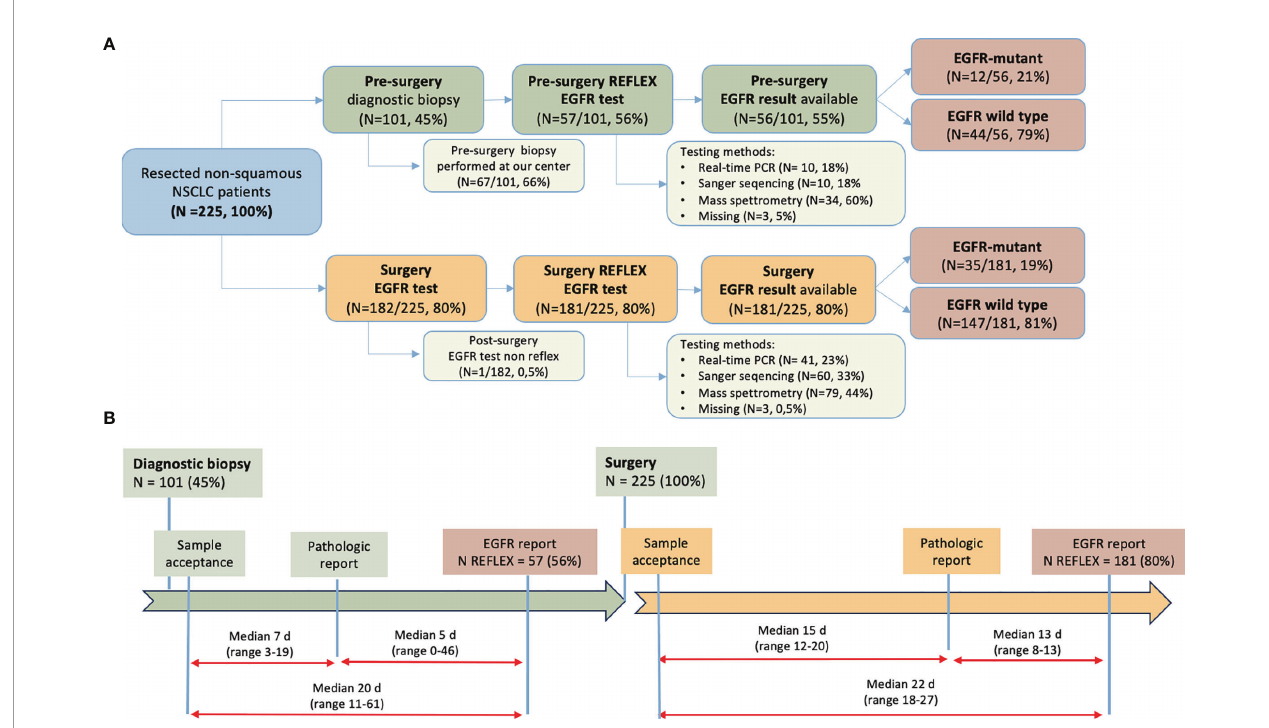
FIGURE 1 | Diagnostic-therapeutic pathway of patients enrolled. (A) Patient fl ow according to EGFR-testing time, material, methods used, and result; (B) Turnaround time between diagnostic procedure and pathological and molecular report, pre- and post-surgery. NSCLC, non-small-cell lung cancer; EGFR, epidermal growth factor receptor; N, number; PCR, polymerase chain reaction; d,